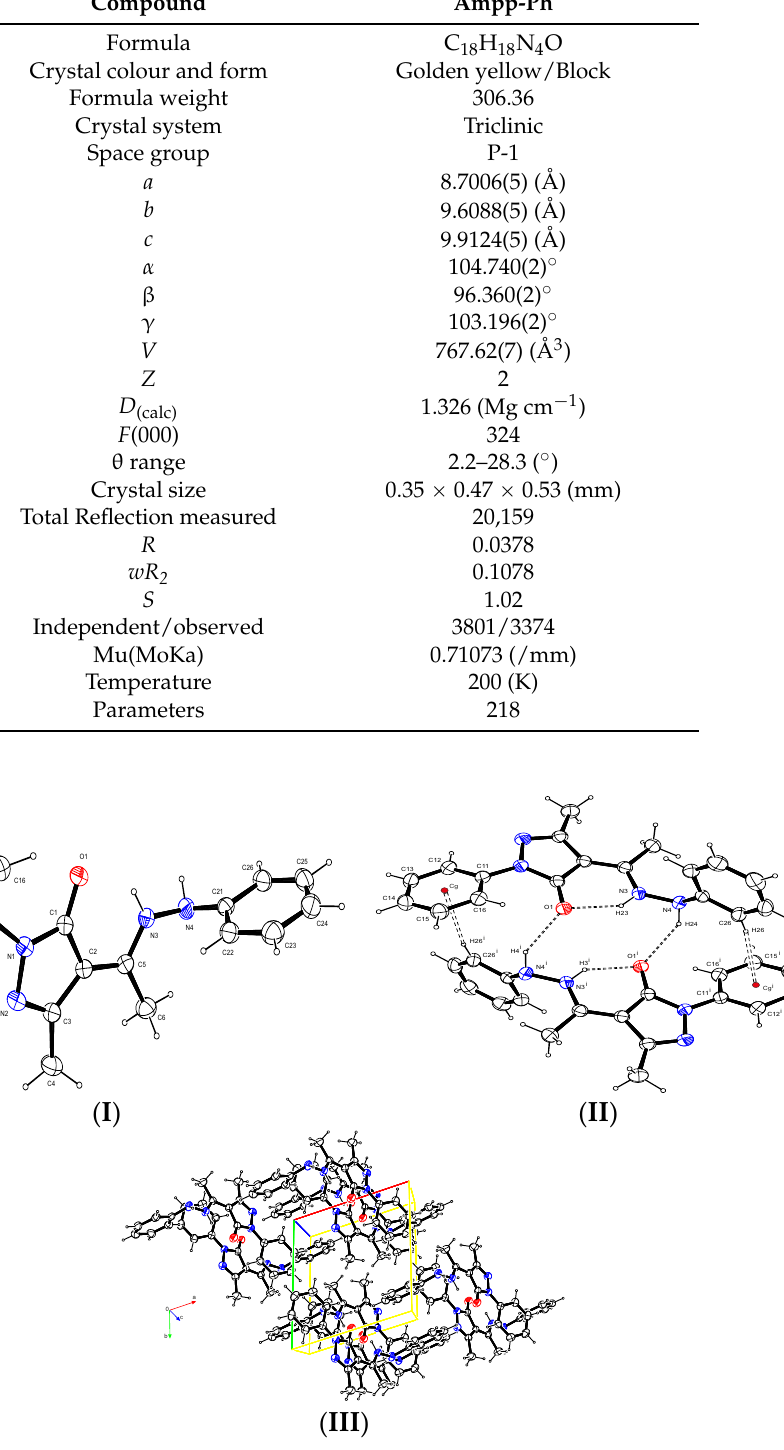
Table 1. Crystal data for Ampp-Ph.